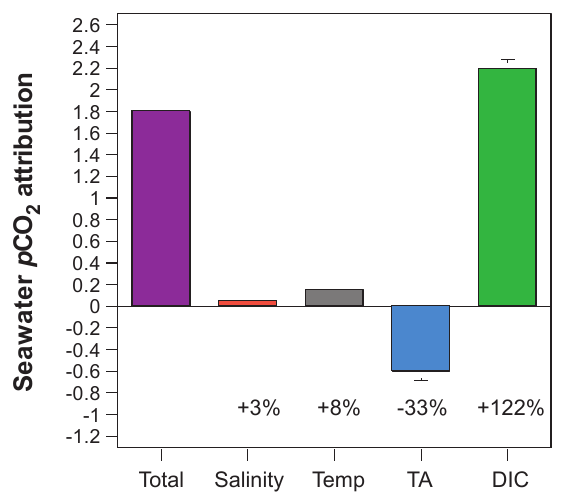
Figure 7 Fig. 7. Long-term trend in seawater p CO 2 (purple) and its attri- bution to long-term changes in salinity, temperature, TA and DIC (green). The relative attribution of change was computed using CO2calc (Robbins et al., 2010) using mean temperature, salinity, TA and DIC values observed at BATS. Mean values and trends taken from Table